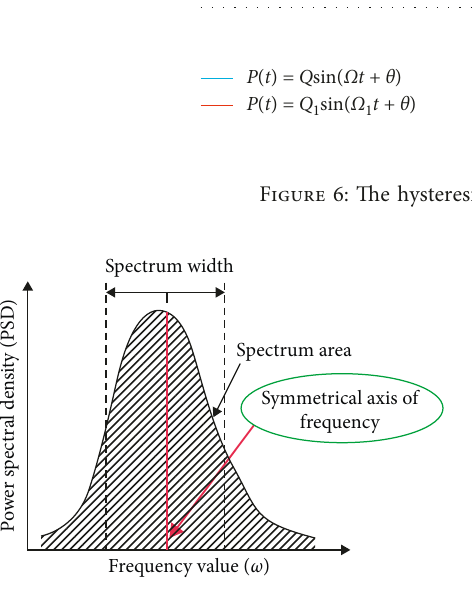
Figure 7: Determination of the central position of the represen- tative power spectral